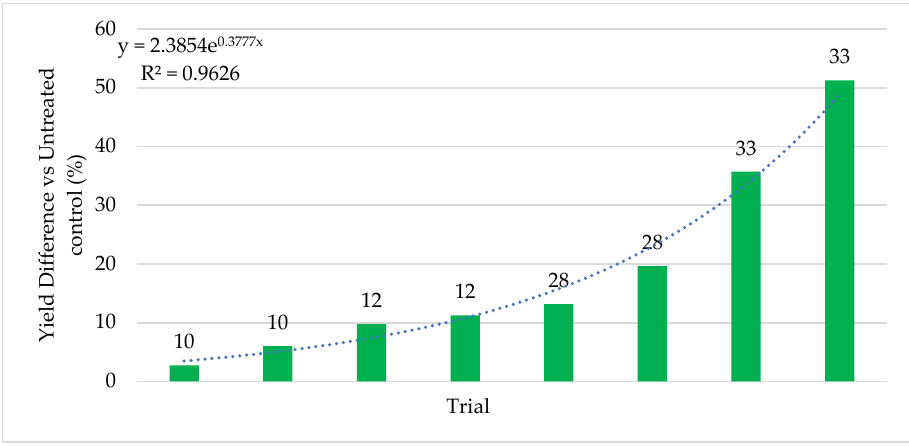
Figure 7. Cotton Percent Yield Difference vs Stress. Stress increases left to right from 10 – 33 with level of stress indicated above each bar as described in the materials and methods. Higher stress levels are indicated by higher numbers. Trials were performed in TX, Australia, and India using four commercial hybrids with Standard PPP’s. Each bar is a separate trial and plots sizes varied from 10 ft × 50 ft to 50 acres. The bars indicate the percent difference in yields of ThMS3a treated versus the untreated control. With increasing stress, increases in yields were observed. Each test had a single replication of treated and untreated so it was not possible to include standard deviations or statistical analysis. Cooperators: CRO’s, seed companies and farmers. To demonstrate the impact of abiotic stress on this symbiotic association, compara- tive studies were done with corn, wheat, and alfalfa to assess ThSM3a benefits under low levels of stress during cultivation. The results with corn were dramatically different with an average yield increase of 3.5% (+323 kg/ha) and a win rate of 69% (tests with yield increases above 1%) (Figure 8).